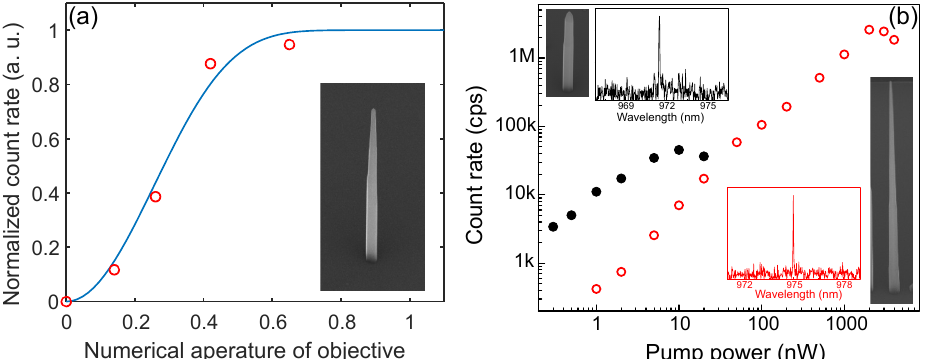
Figure 9. ( a ) Normalized exciton photon emission rate measured at saturation as a function the NA of the collection objective (open circles) for the nanowire device shown in the inset. The blue line is the calculated power, P t ( θ ) , transmitted across the base of a cone having an apex angle 2 θ using S NA = 0.53. ( b ) Count rates of single exciton lines as a function of excitation power for a quantum dot embedded in an untapered (solid black circles) and conically tapered (empty red circles) nanowire. Top left (bottom right) insets show an SEM image and a PL spectrum for the untapered (tapered)